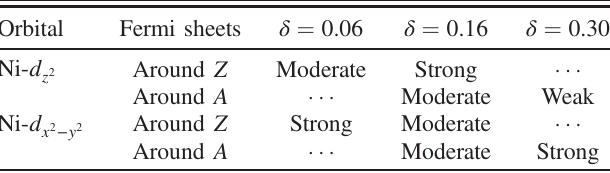
TABLE II. Qualitative orbital-character strength on the inter- acting Fermi-surface sheets in the k hole dopings. See bottom right of Fig. 11 for a visualization of both Fermi